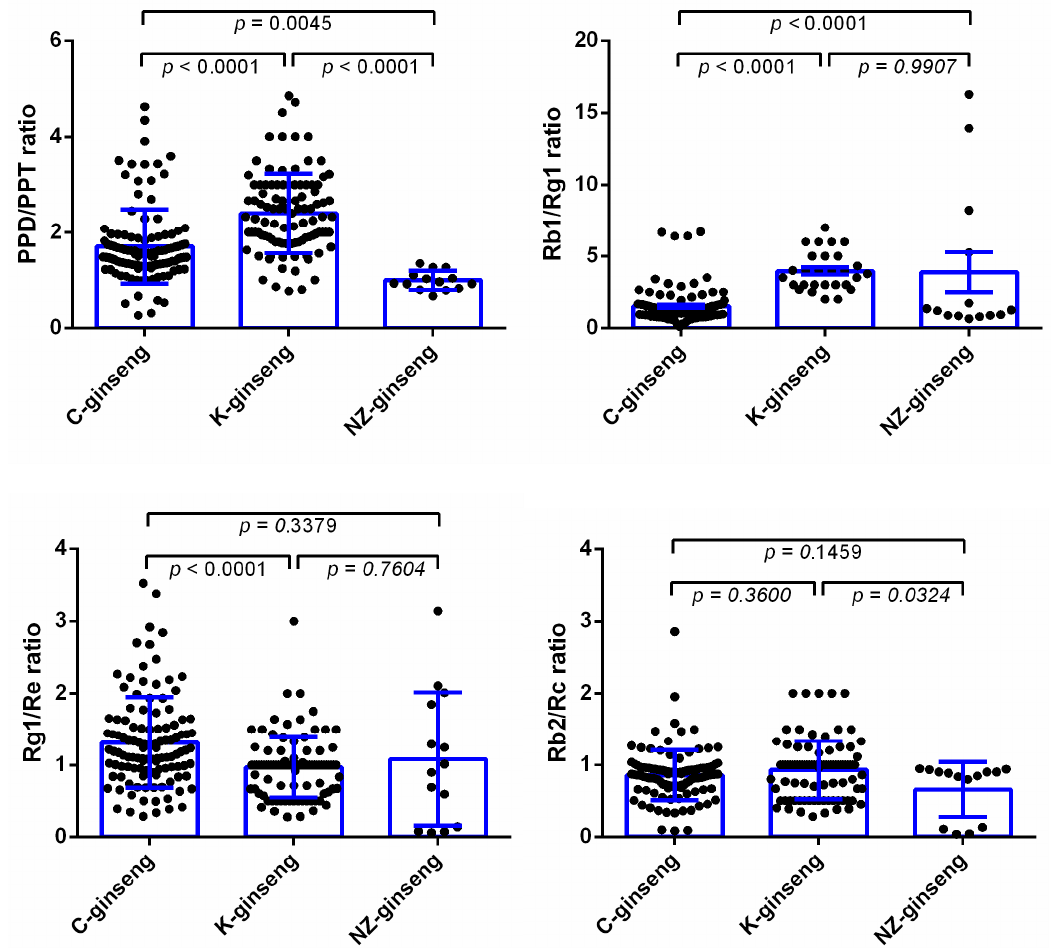
Figure 5. The PPD/PPT, Rb1/Rg1, Rg1/Re, and Rb1/Rc ratios of ginsenosides in the ginseng roots grown in three different countries. Data were analyzed by one-way ANOVA using Graph pad prism 6 software and expressed as mean ± SE. Differences were considered significant if p < 0.05. Each dot represents one batch of ginseng sample test datum. C, K, and NZ-ginseng refers to China (n = 113), Korea (n = 106), and New Zealand (n = 14) grown ginseng, respectively.